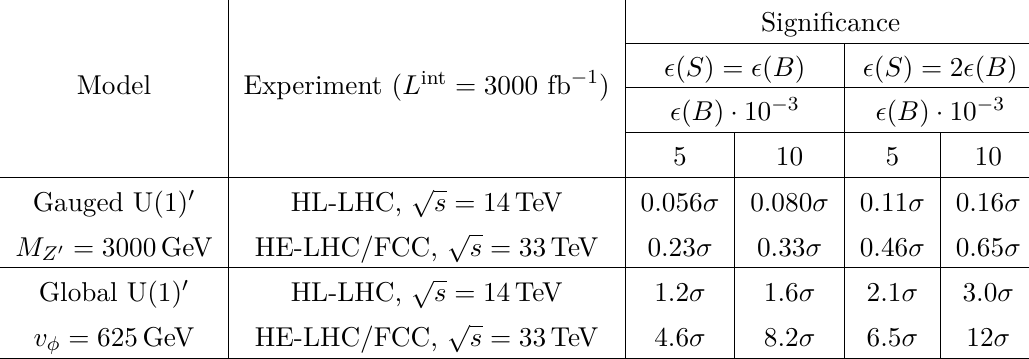
Table 5. Significances for the gg → φ → tT → tth 0 signal with M φ = 1250 GeV and the parameter setup given in equation (6.3) for four values of acceptance × selection efficiency: on the left the total signal efficiency is equal to the background one, (cid:15) ( S ) = (cid:15) ( B ) , while on the right it is twice the